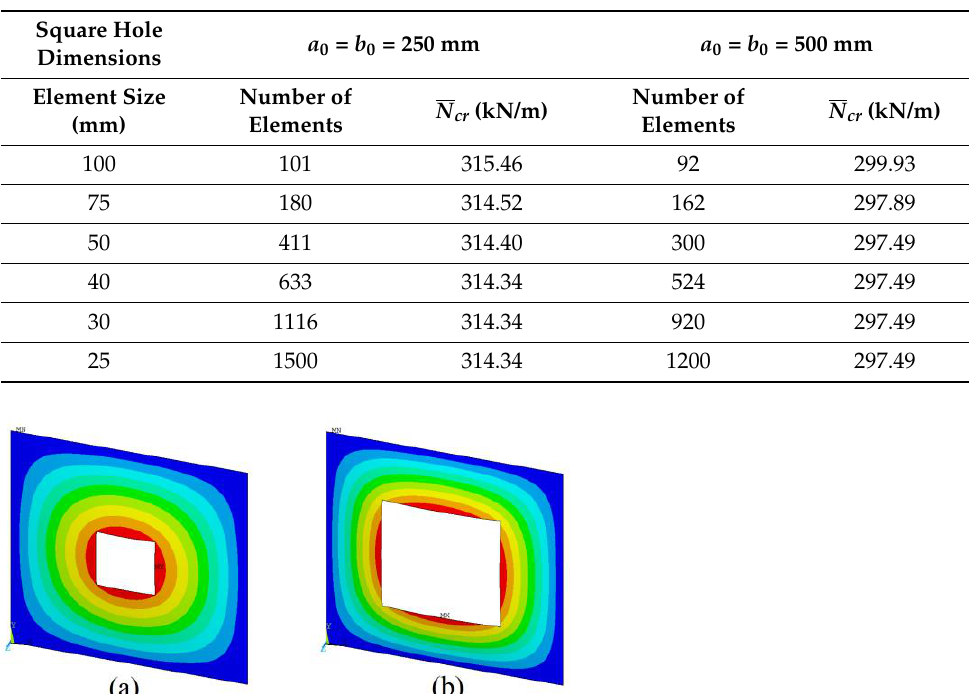
Table 2. Mesh convergence test for the verification of the computational model by Jayashankarbabu and Karisiddappa [24].